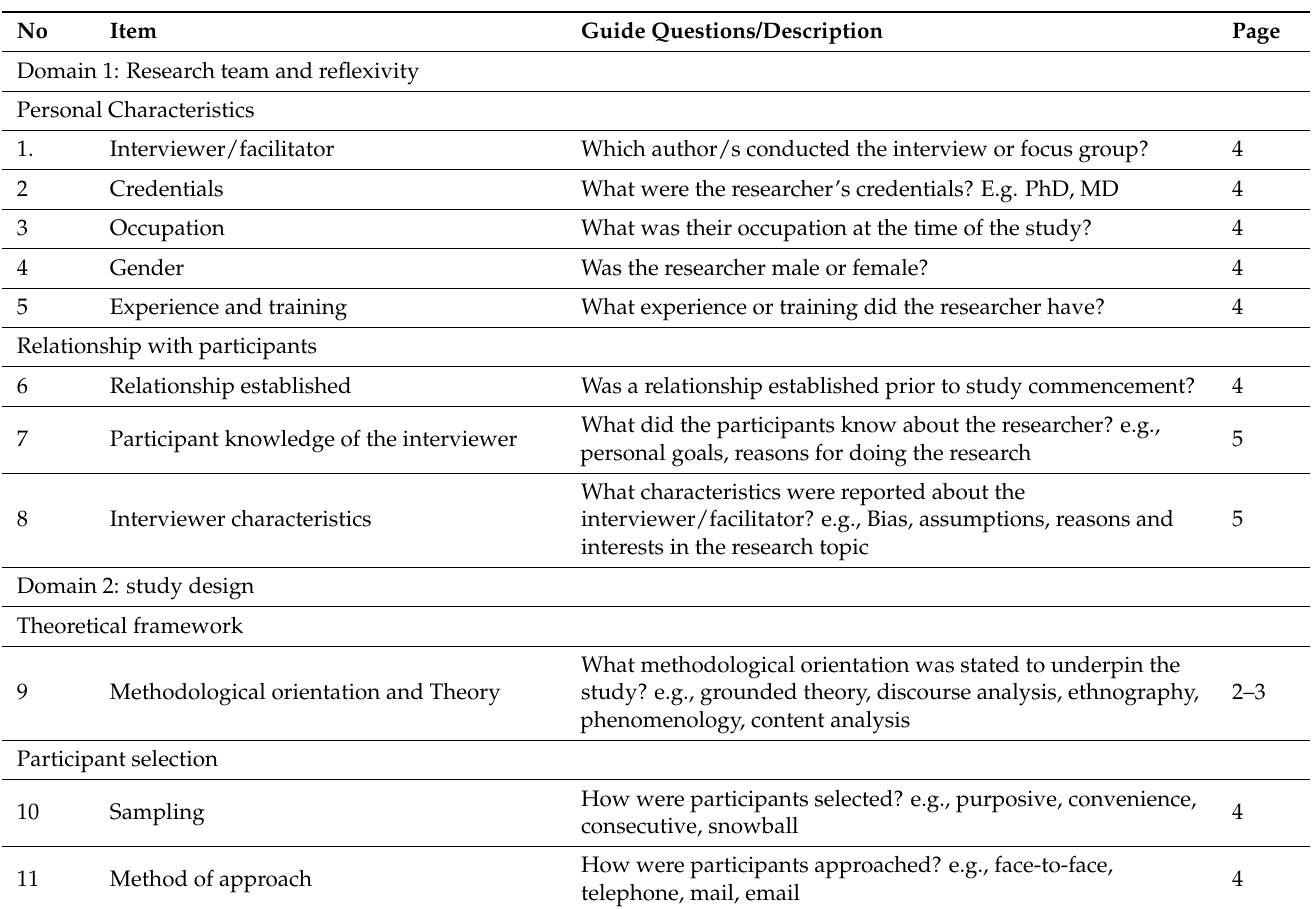
Table A1. Consolidated Criteria for Reporting Qualitative Studies (COREQ): 32-Item